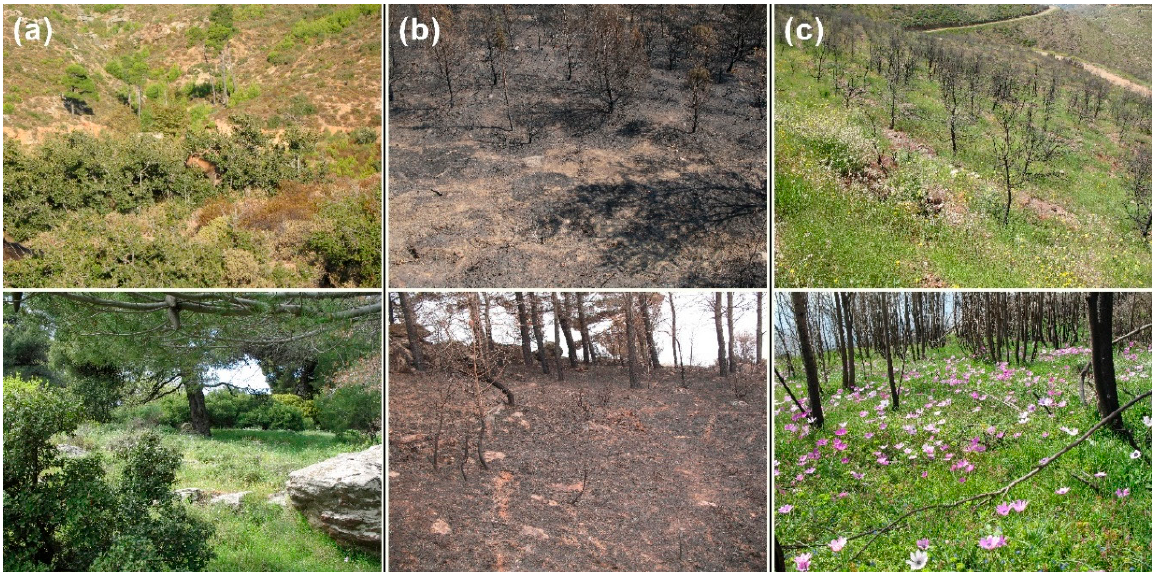
Figure 7. Illustration of characteristic examples of the vegetation cover changes due to forest fires; ( a ) before the forest fire, ( b ) just after the forest fire, ( c ) first years after the forest fire (wet period).